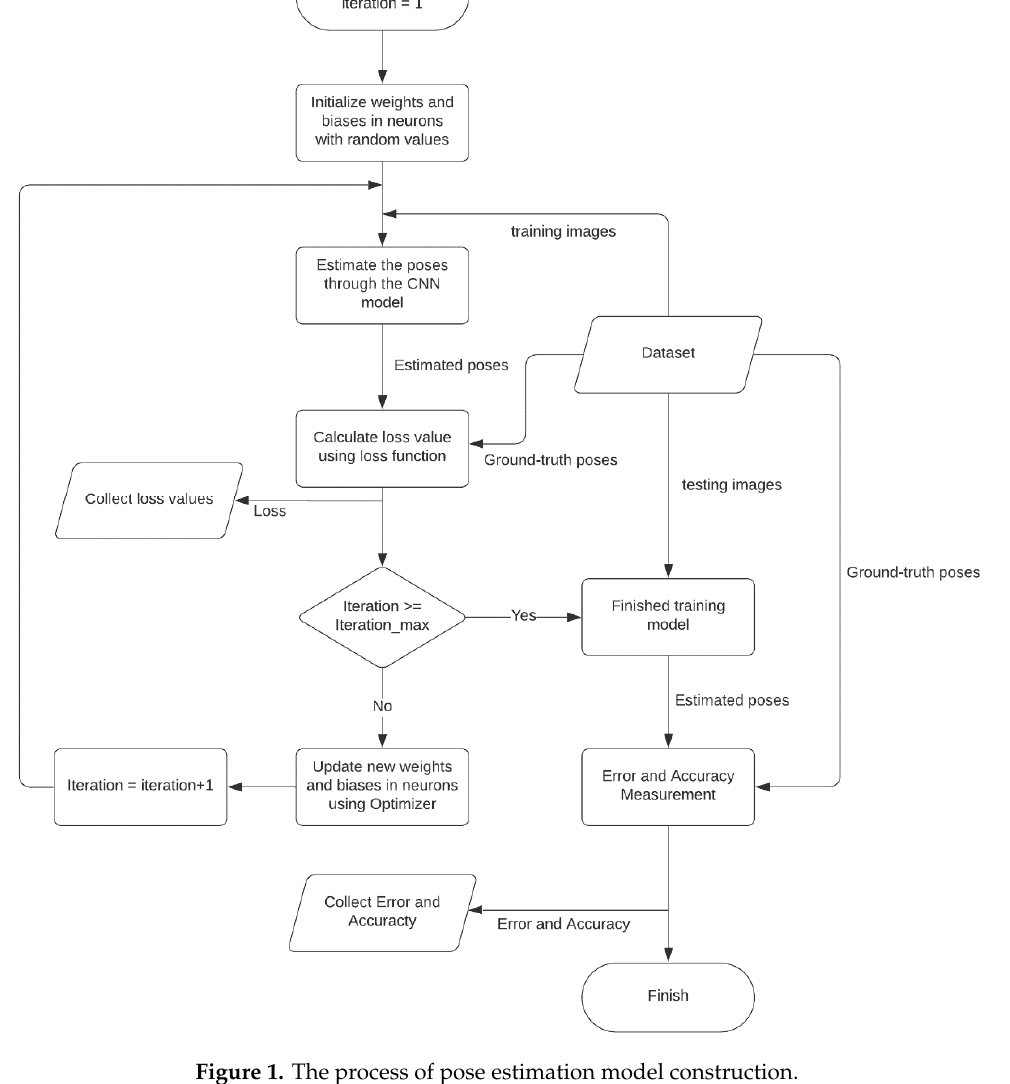
Figure 1. The process of pose estimation model construction.